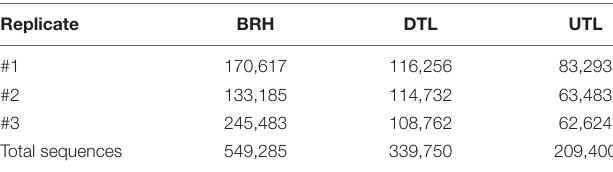
TABLE 1 | Bovine rawhides (BRHs), red damaged tanned leathers (DTLs), and undamaged tanned leathers (UTLs) sample yields from each replicate (#1, 2, 3).